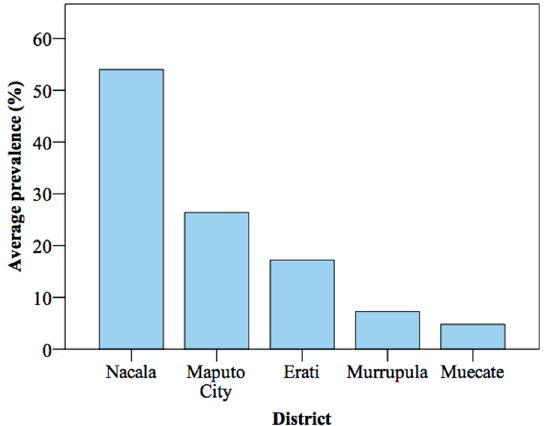
Figure 5. The districts with highest aflatoxin prevalence. Based on Casadei [6], Van Rensburg et al. [7], van Wyk et al. [1], Warth et al. [2] and Sineque et al. [8]. These studies were carried from 1985 to 2017 and included in total 934 samples including agricultural crops, chicken livers and gizzards.